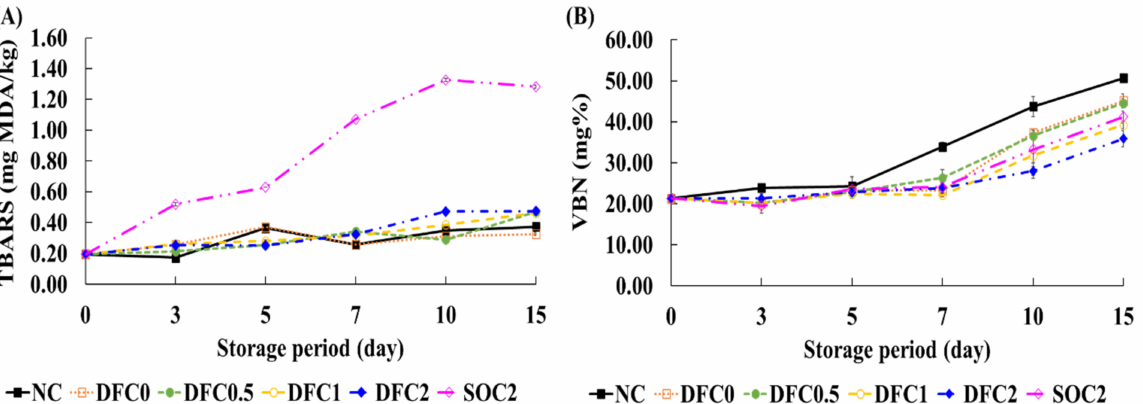
Figure 3. TBARS and VBN values of coated chicken meat during storage at 4 ± 1 ◦ C for up to 15 days. ( A ) Thiobarbituric acid reactive substances (TBARS) and ( B ) volatile basic nitrogen (VBN) values were determined during storage at 4 ± 1 ◦ C for up to 15 days. NC, non-coated; DFC0, coated with duck fat, with no chitosan; DFC0.5, coated with duck fat and 0.5% chitosan; DFC1, coated with duck fat and 1% chitosan; DFC2, coated with duck fat and 2% chitosan; SOC2, coated with soybean oil and 2% chitosan. The error bars indicate SD ( n =